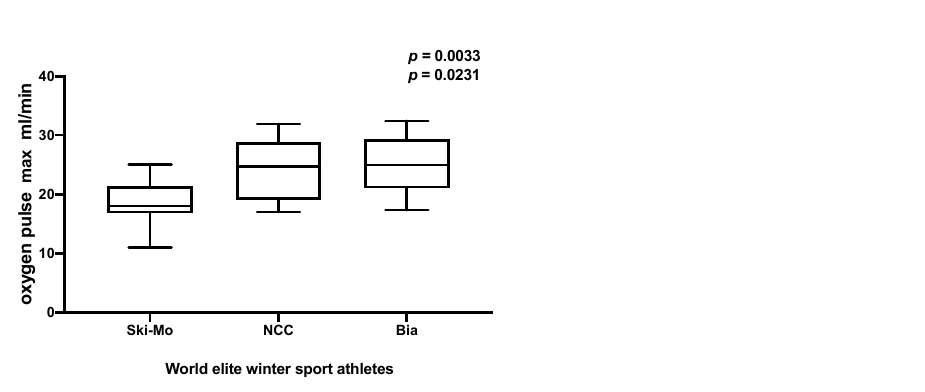
Figure 3. Analysis of maximum oxygen pulse in world elite winter sport professionals ( p = 0.0033, p = 0.0231), modified from Zimmermann et al., 2022 [22].